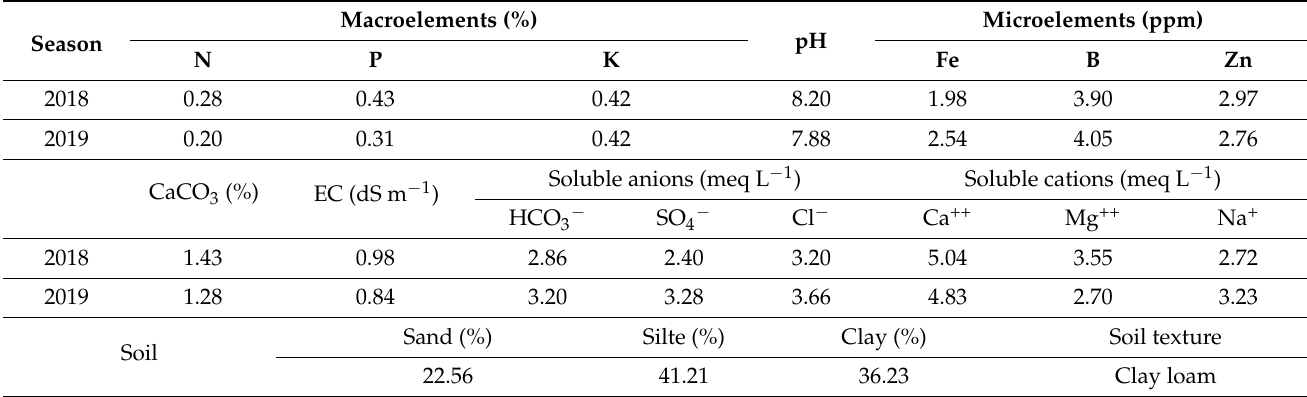
Table 1. Chemical and physical properties of the experimental soil.